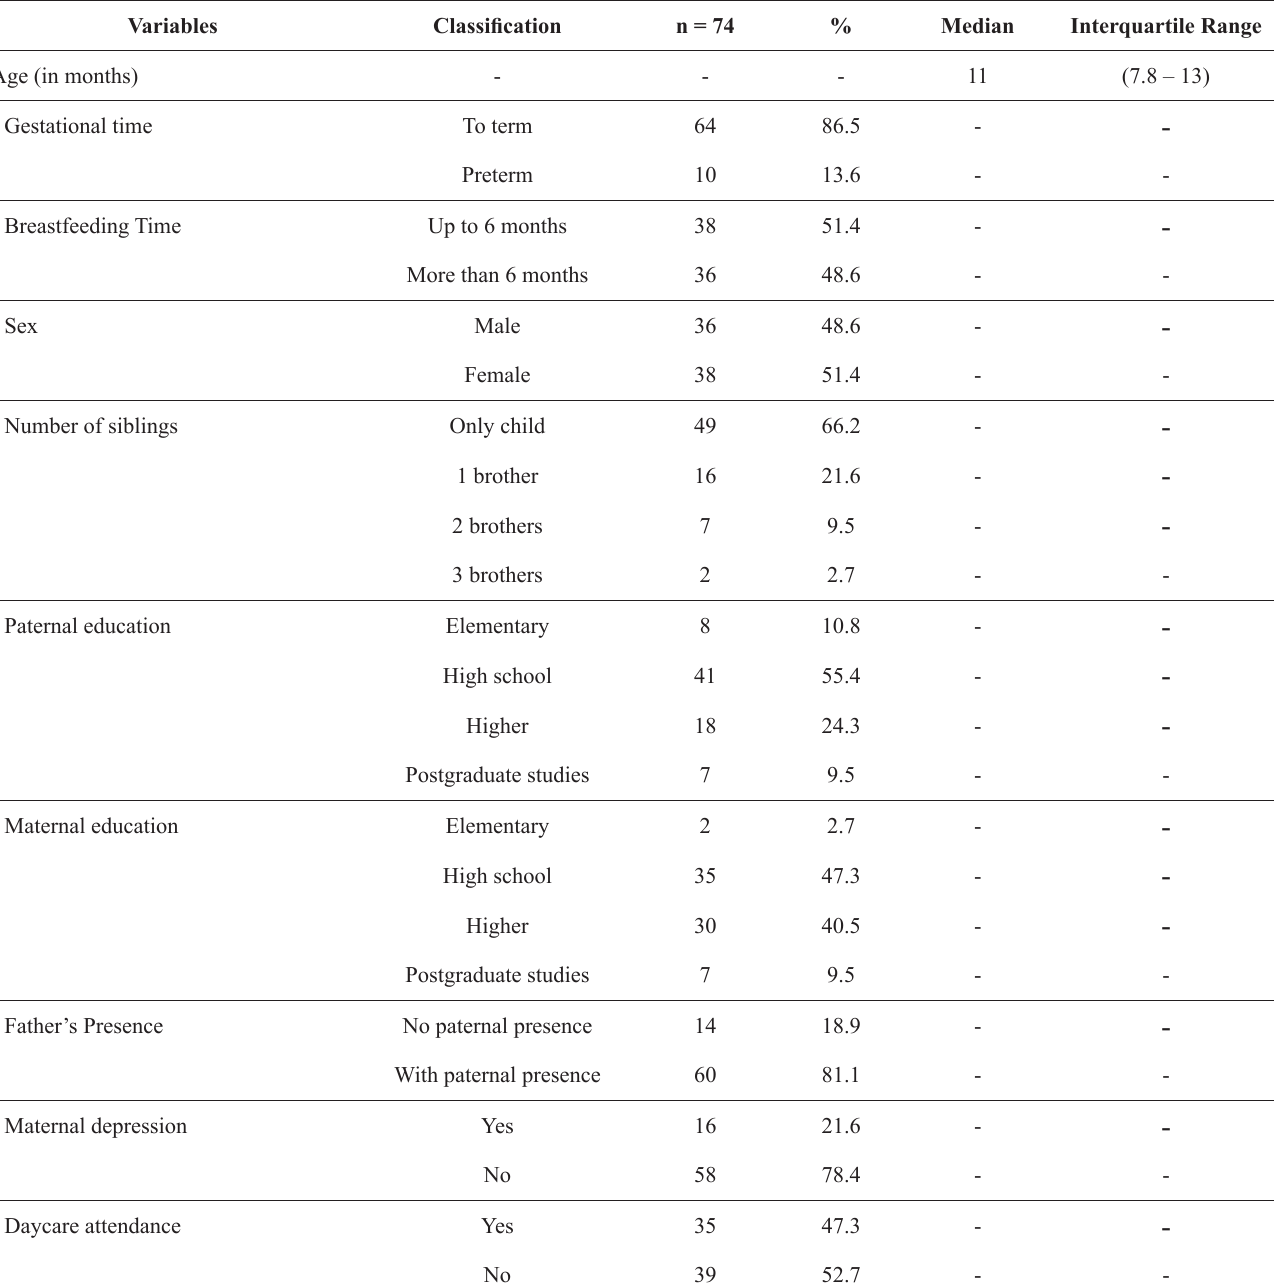
Table 1 - Characteristics of the participants (n =